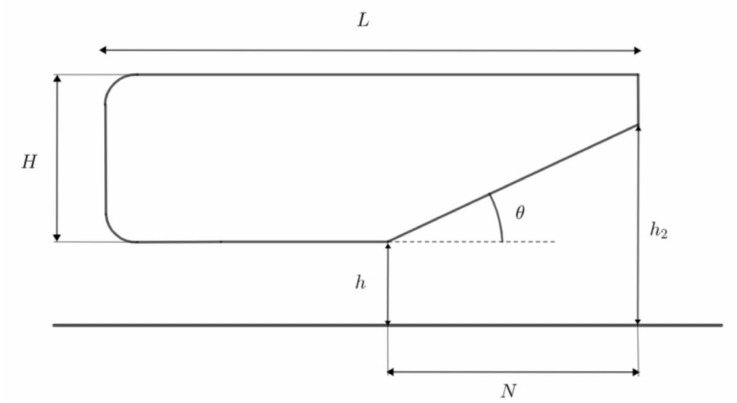
Figure 3. Schematic representation of a bluff body with an added diffuser